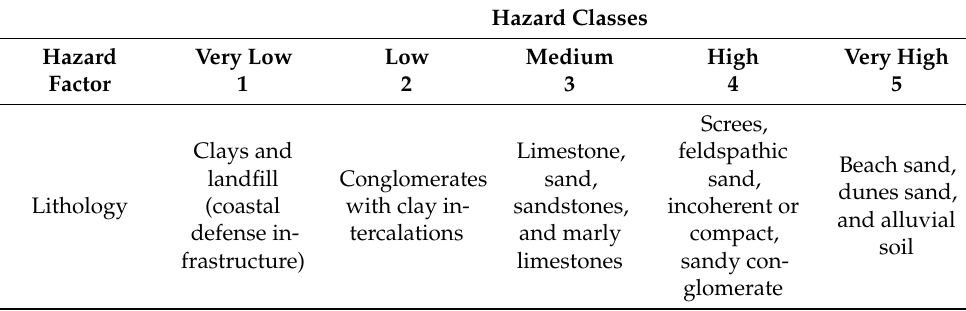
Table 4. Hazard classification concerning the lithology hazard